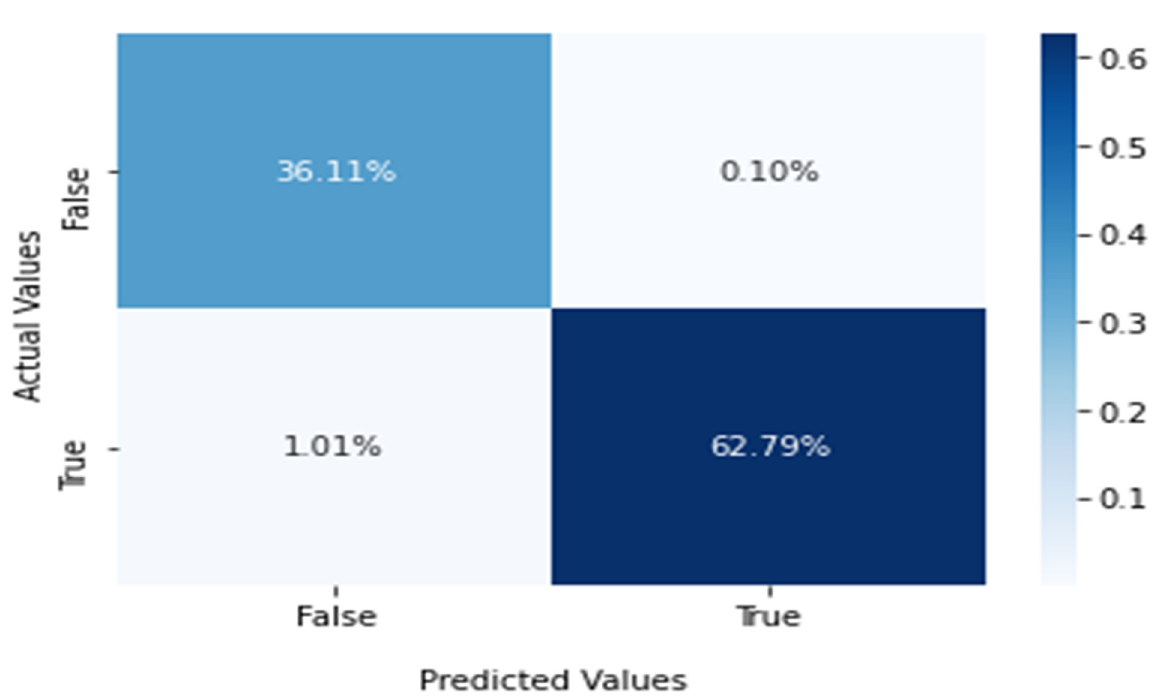
Figure 9. Confusion metrics of the CNN-LSTM model using the binary dataset.